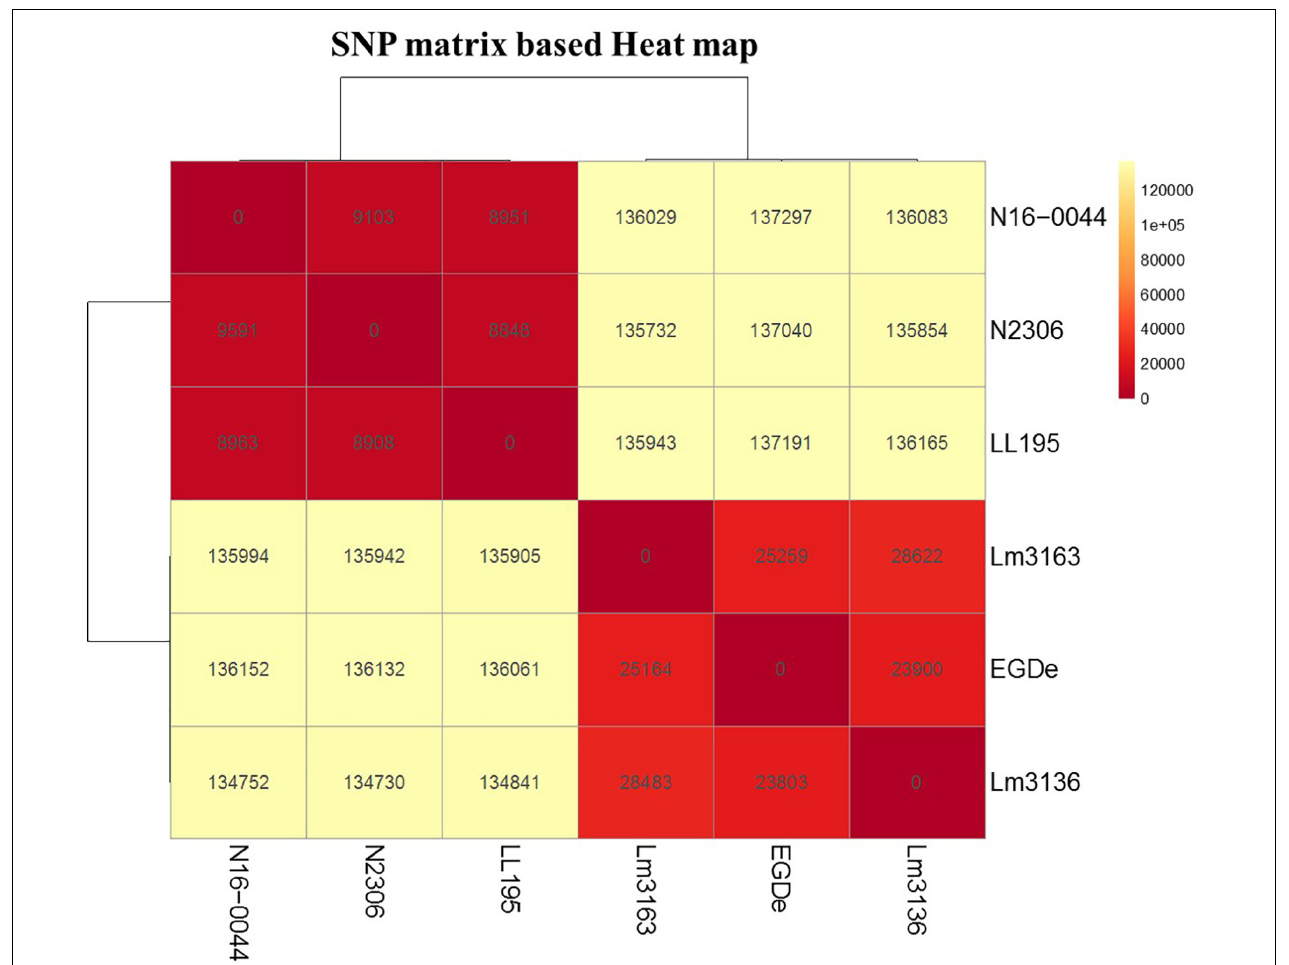
FIGURE 8 | SNP matrix-based heatmap showing the variation in core genome SNPs between strains examined in this study.